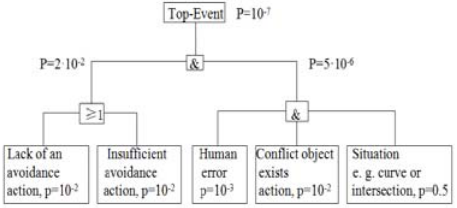
Fig. 6 General scheme for occurrence of